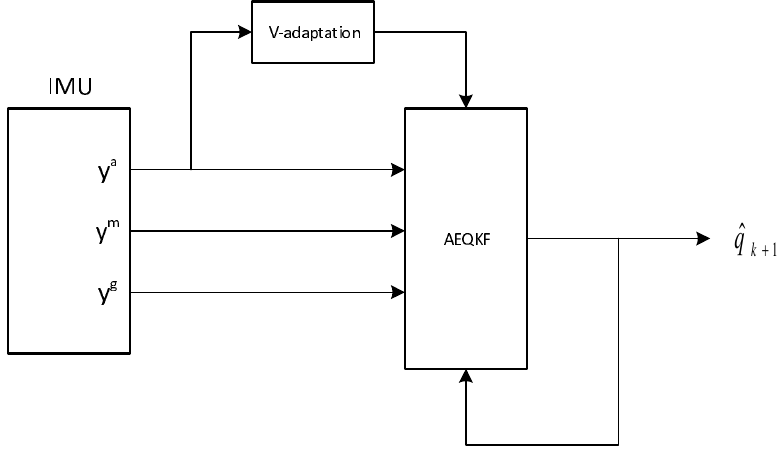
Figure 7. The AEQKF flow